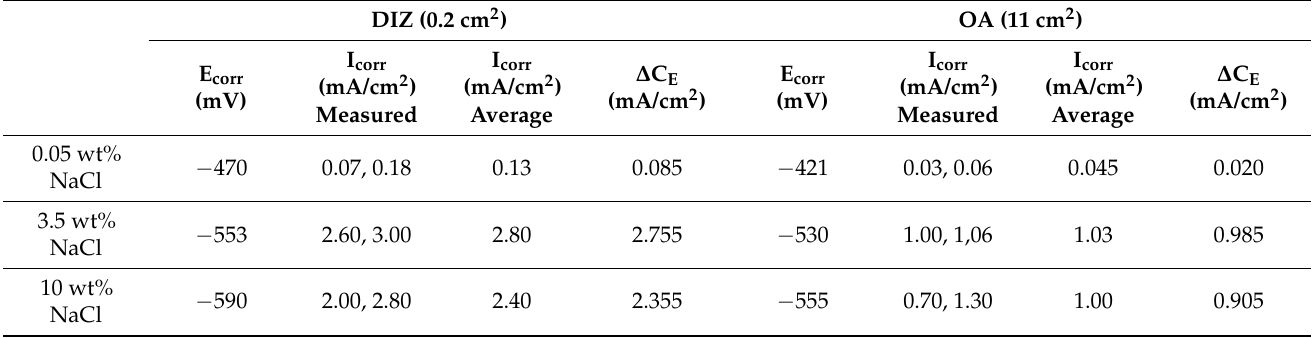
Figure 14. Polarisation plots for segmented UNS G43400 steel specimens in SLEC conditions. Table 11. Electrochemical measurements for UNS G43400 segmented sample in all test salinities.